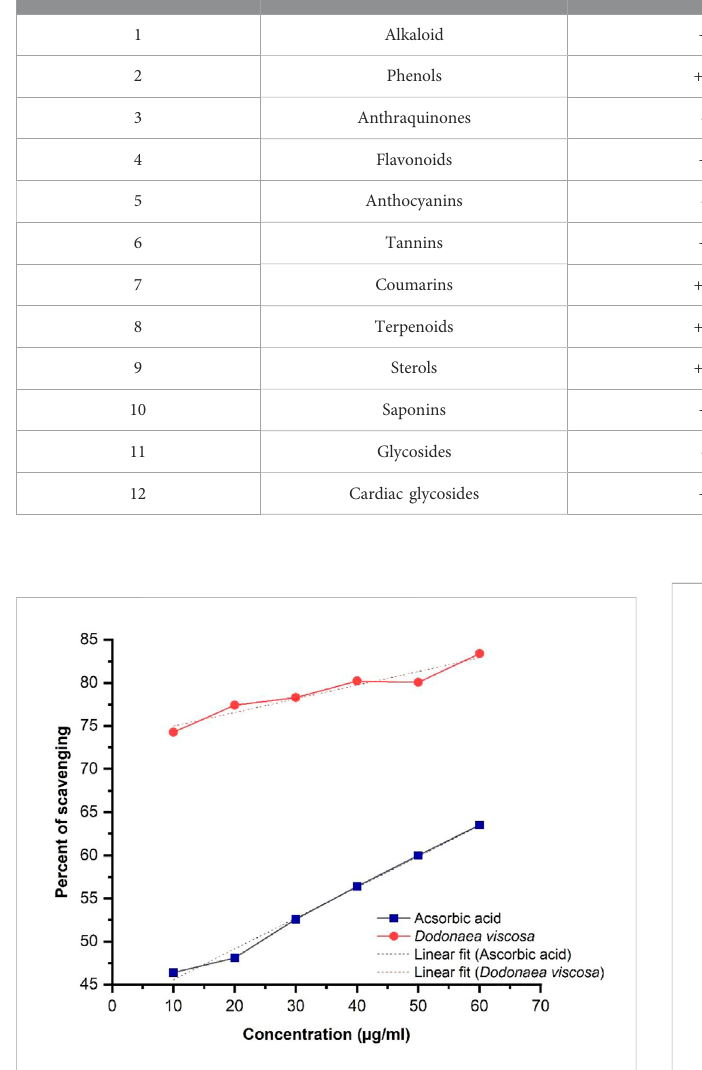
TABLE 2 Phytochemical testing results of Dodonaea viscosa extract. S. No.